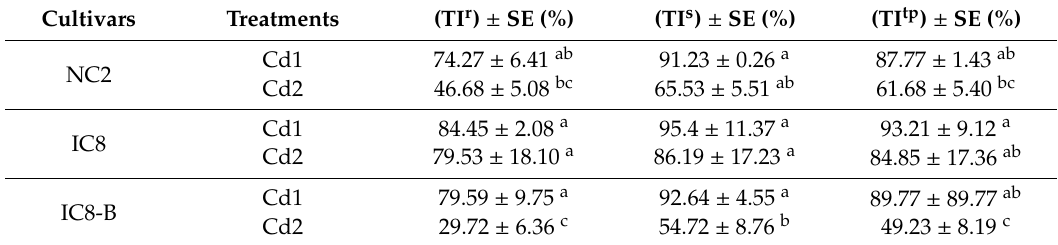
Table 5. Dry weight tolerance indices for root (TI r ), shoot (TI s ) and total plant (TI tp ) of chickpea seedlings grown in a nutrient medium under Cd stress at the rate of 25 µ M (Cd1) and 50 µ M (Cd2) with mean values ± SE, ( n = 3).